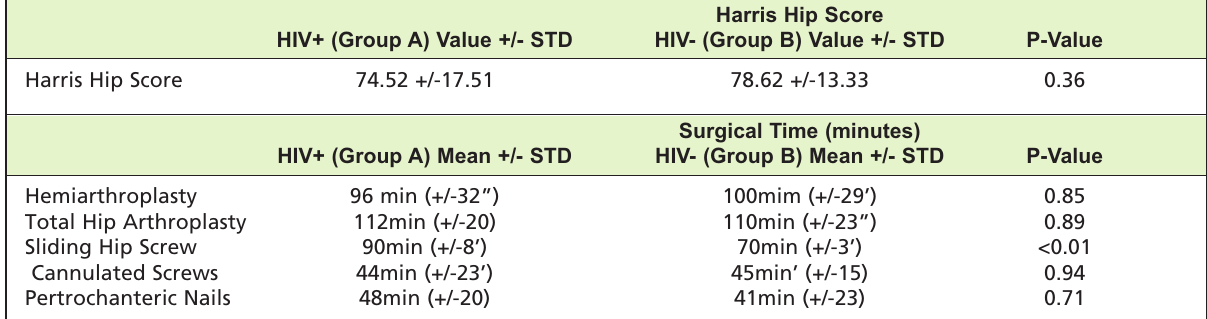
Three months follow-up Harris Hip Score and surgical time Table II: